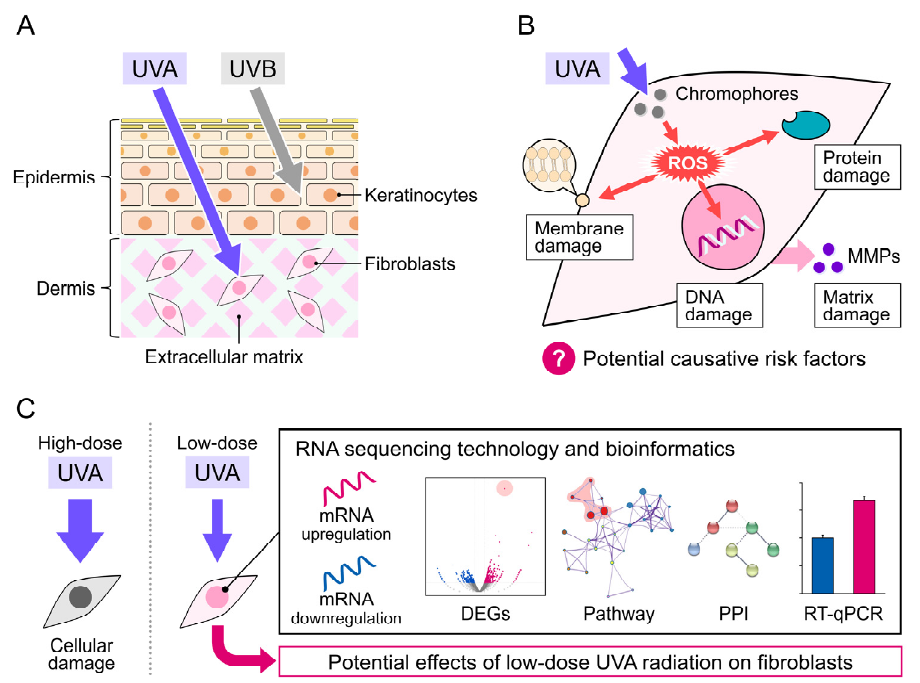
Figure 1. Mechanism of UVA damage to the skin. ( A ) UVA penetration into the skin dermis layers. ( B ) UVA-induced damage to cellular DNA, protein, and membrane via ROS production in skin fibroblasts. ( C ) Schematic diagram of this study.